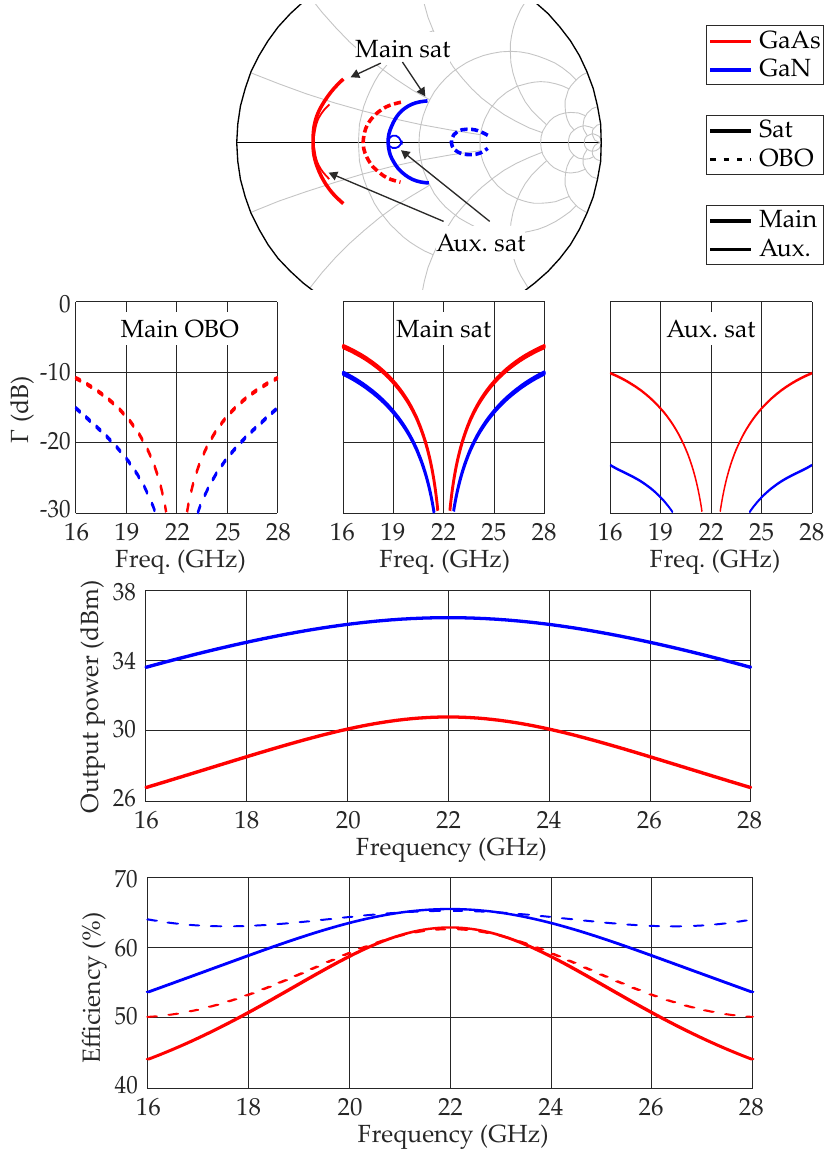
Figure 5. Comparison of the simulated frequency response of the combiner of a single-device DPA in GaAs (red) and in GaN (blue), at saturation (solid) and at 6 dB back-off (dashed). From top to bottom: synthesized loads at the current generator planes, saturated output power, efficiency.